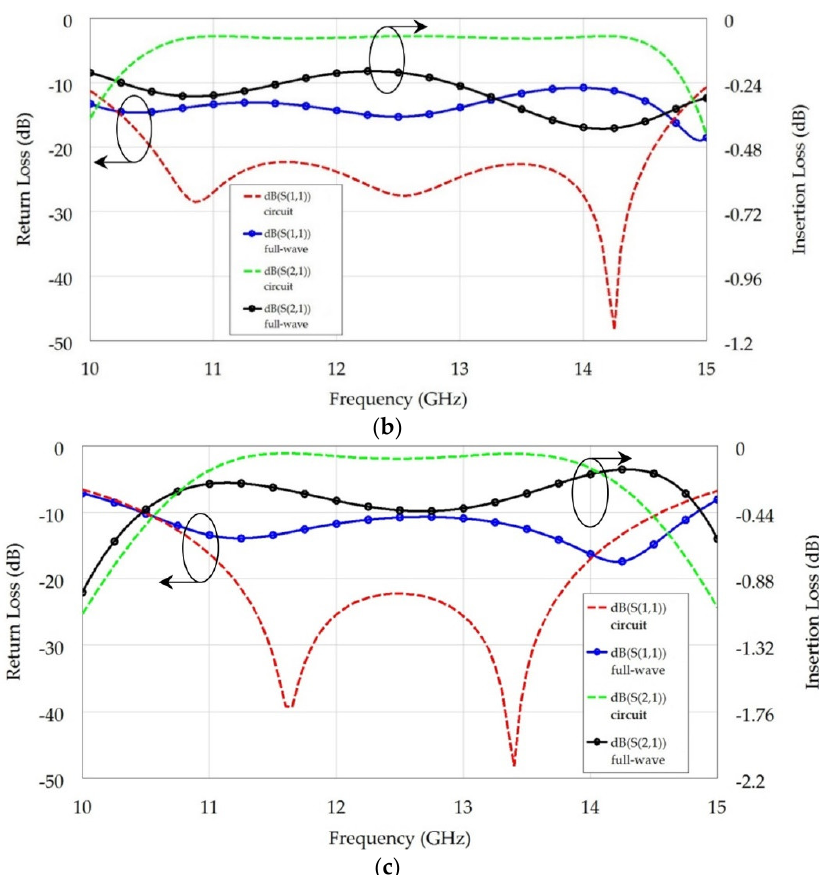
Figure 8. Circuit and full-wave simulated scattering parameters for three matching networks. ( a ) One iris; ( b ) Two irises; ( c ) Three irises.